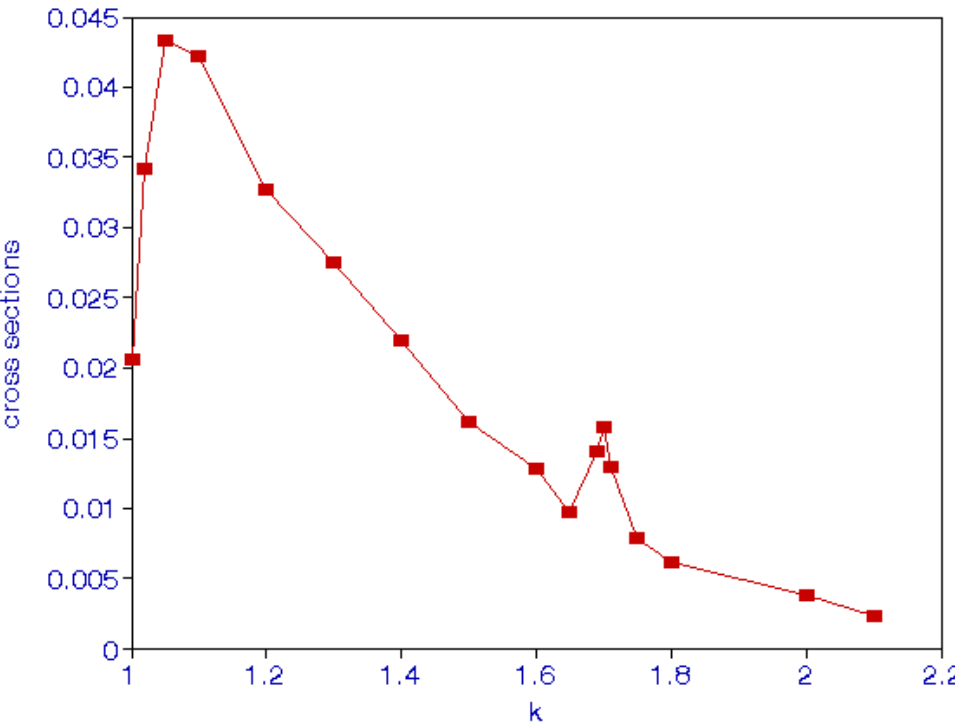
Figure 5. (Color online) Total 1 S to 6 S excitation cross sections ( π a 2 k (Ryd).